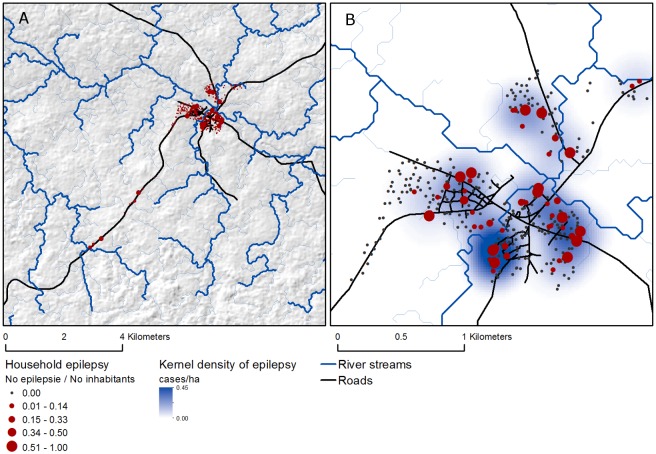
Overview of study area (a) and Titule village (b) showing the point locations and smooth kernel density estimation (300 m radius) of epilepsy in the area as well as the location of roads and rivers.